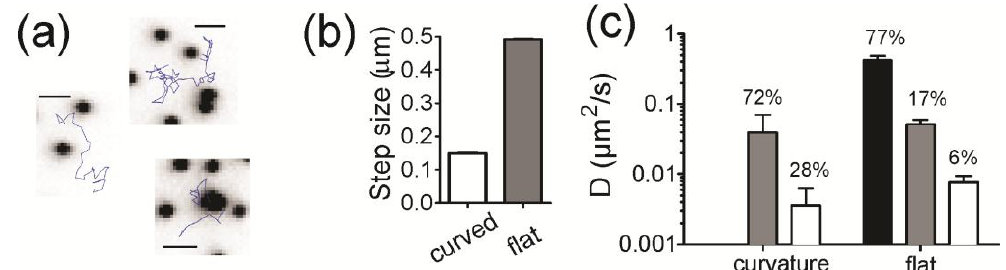
Figure 5. Single Biotin-X-DHPE molecules tagged with Streptavidin-Alexa546 were tracked on the curved supported lipid bilayers (ROC = 28 nm) in space and time. ( a ) example trajectories (blue) show the heterogeneous dynamics observed on both flat (white) and curved (black) regions. Scale bar = 1 µm; ( b ) the average step a molecule takes over 0.228 s (5 frames) when starting at a region of curvature (white) or at a flat region (grey); ( c ) the distribution of steps observed at curved and flat regions (shown in Figure S3) was fitted to Equation 3 to obtain the diffusion coefficients and the percentage of steps moving at that rate. The average D is plotted for t = 0.091, 0.228 and 0.456. Note that there is no fast component for the tracks that start at regions of curvature.